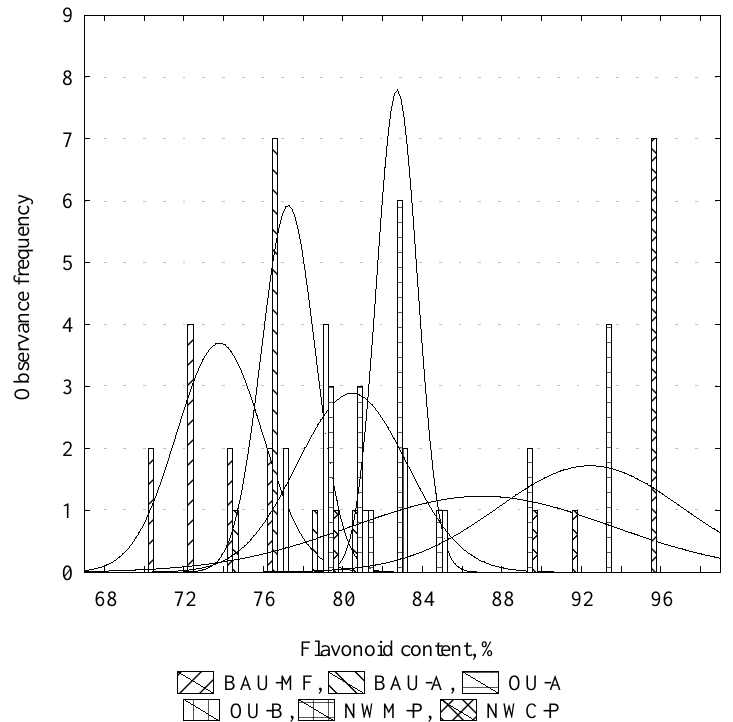
Fig. 5. Normal distribution of flavonoid amount content values in rutin samples depending on carbon